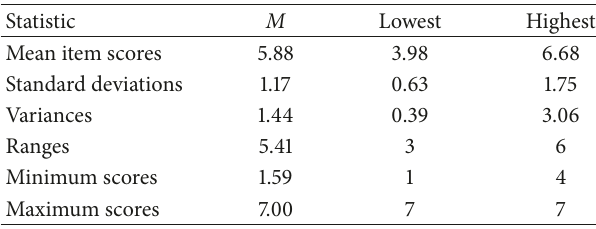
Table 1: Means and ranges for scale item